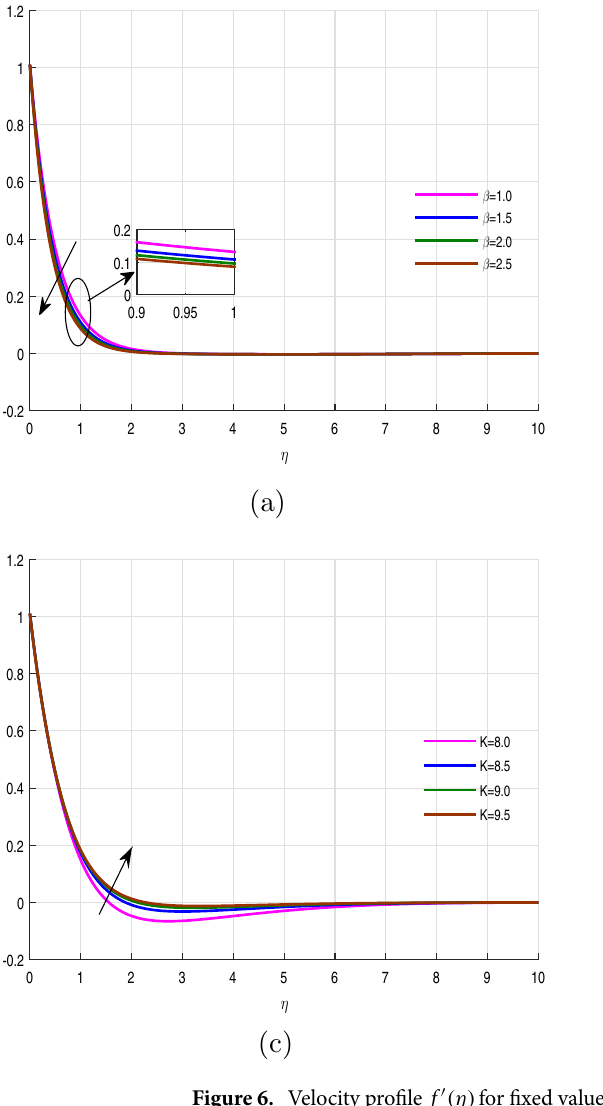
Figure 6. Velocity profile f ′ (η) for fixed values of physical parameters (cid:31) = 0.1 k = 8.933 , Pr = 6.0 , M = 0.5 , Gr = 0.09 , Gc = 0.05 , σ 1 = 1.1 , σ 2 = 10.9 , R = 0.5 , Ec = 0.6 , Nb = 0.01 , Nt = 0.1 Sc = 9.0 , fw = 1.0 , ϕ = 0.2 , n = 0.01 and β = 2.5